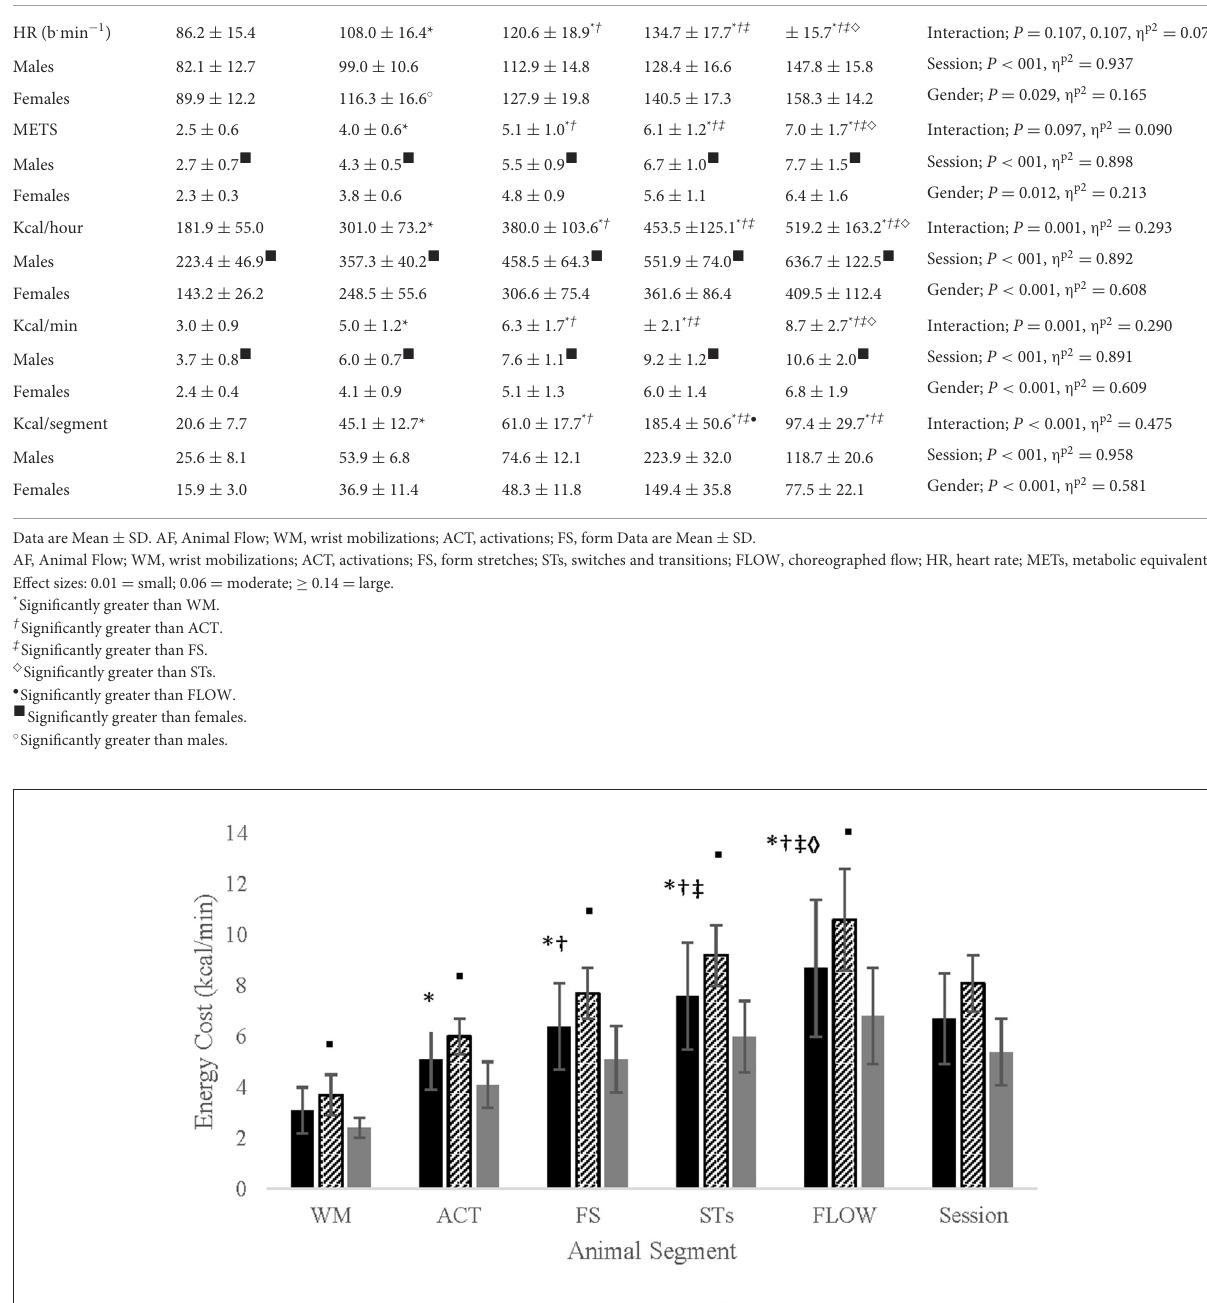
TABLE 4 Comparison of HR, METs, and energy expenditure across segments of AF ( n = 30). Variable